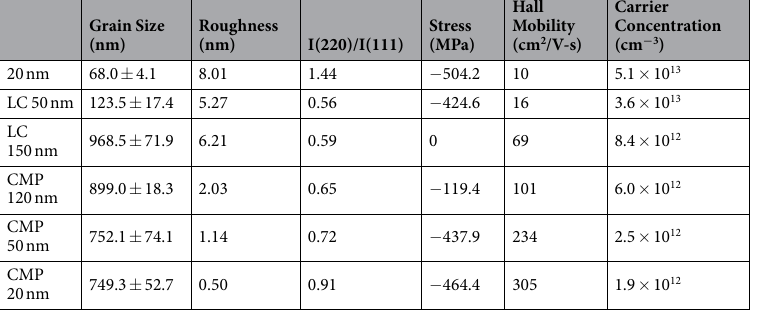
Table 1. Material properties of laser crystallized a-Si thin films and CMP planarized poly-Si thin